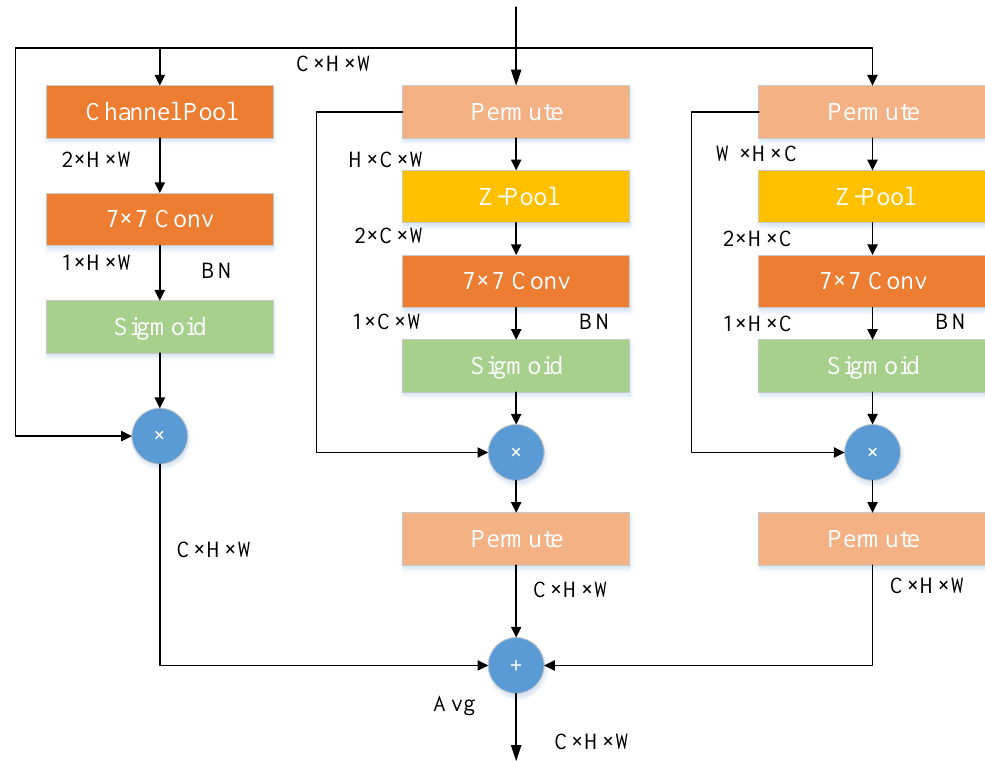
Figure 5. Detailed architecture of transform